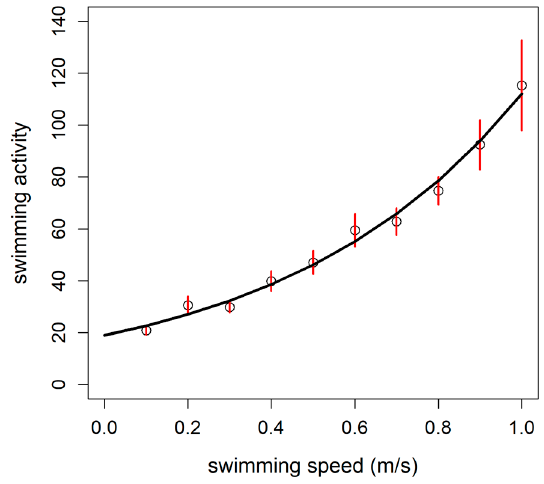
Figure 4. Exponential model (y = α e β x ) of rainbow trout ( Oncorhynchus mykiss ) swimming activity as a function of the swimming speed (m/s). The estimated parameters for the exponential model were as follows: α = 18.98 ± 2.41; β = 1.77 ± 0.15 (n = 10 fish; mean ± standard error).